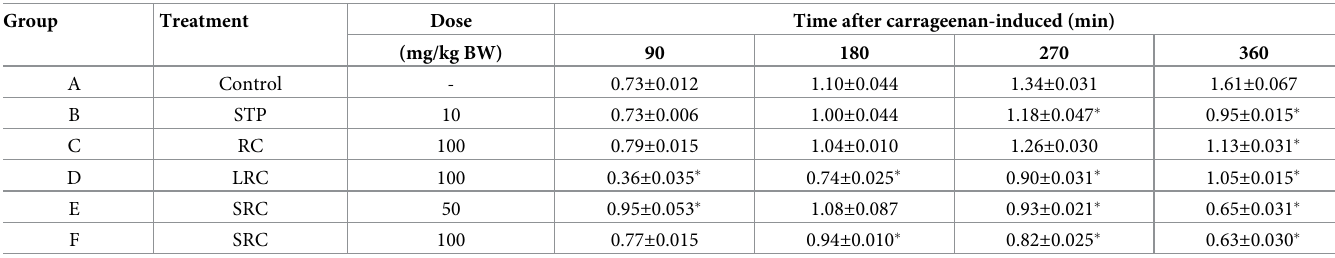
Table 2. The different size between left and right paw (mm).